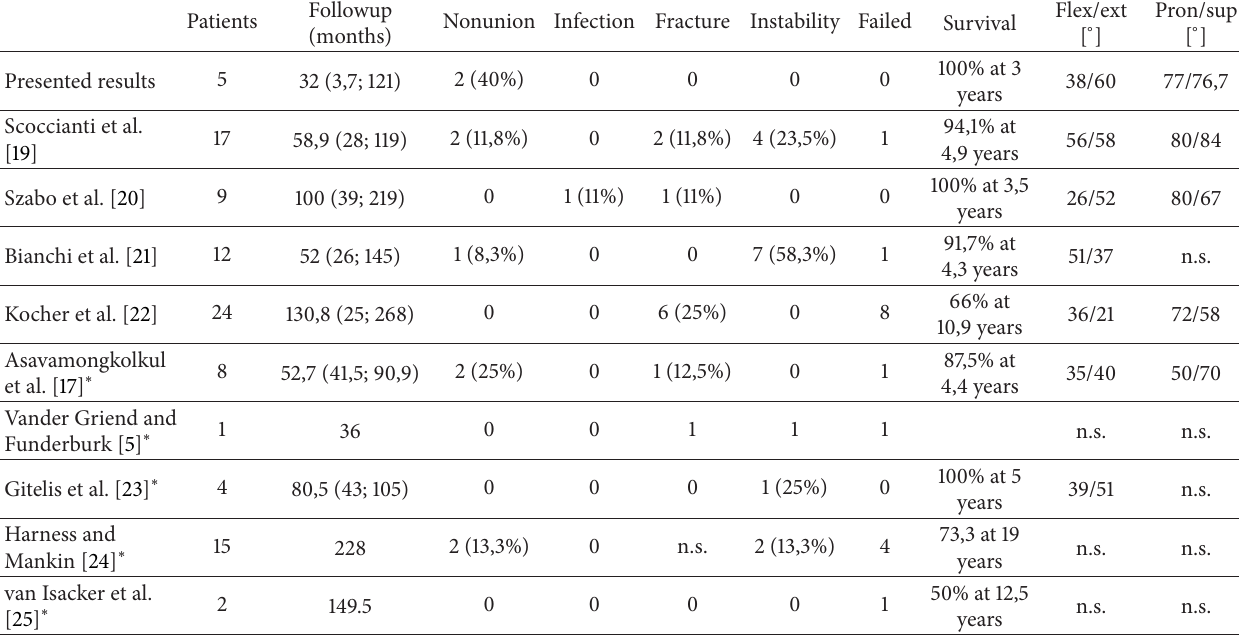
Table 1: Osteoarticular allograft reconstructions at distal radius: comparison of